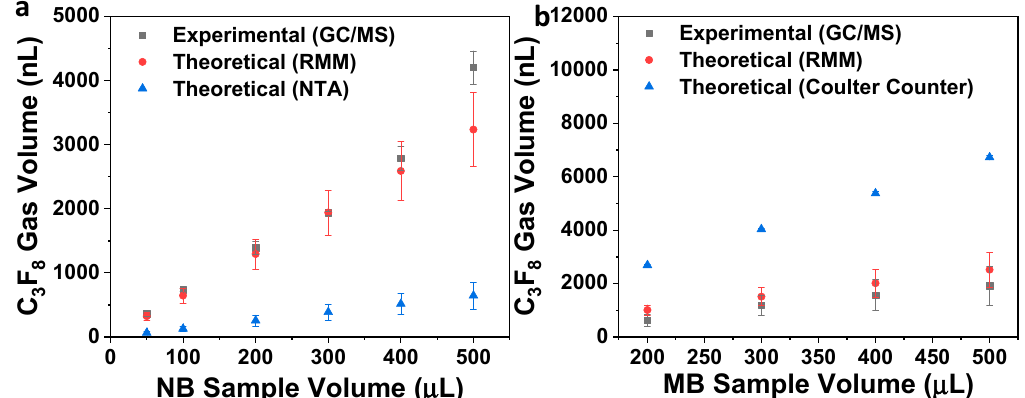
Figure 3. Comparison of perfluoropropane (C 3 F 8 ) gas volume determined experimentally using headspace gas chromatography/mass spectrometry (GC/MS) and theoretically predicted based on RMM and Coulter counter size and concentration measurements at different experimental bubble sampling volumes for ( a ) nanobubbles and ( b ) microbubbles.